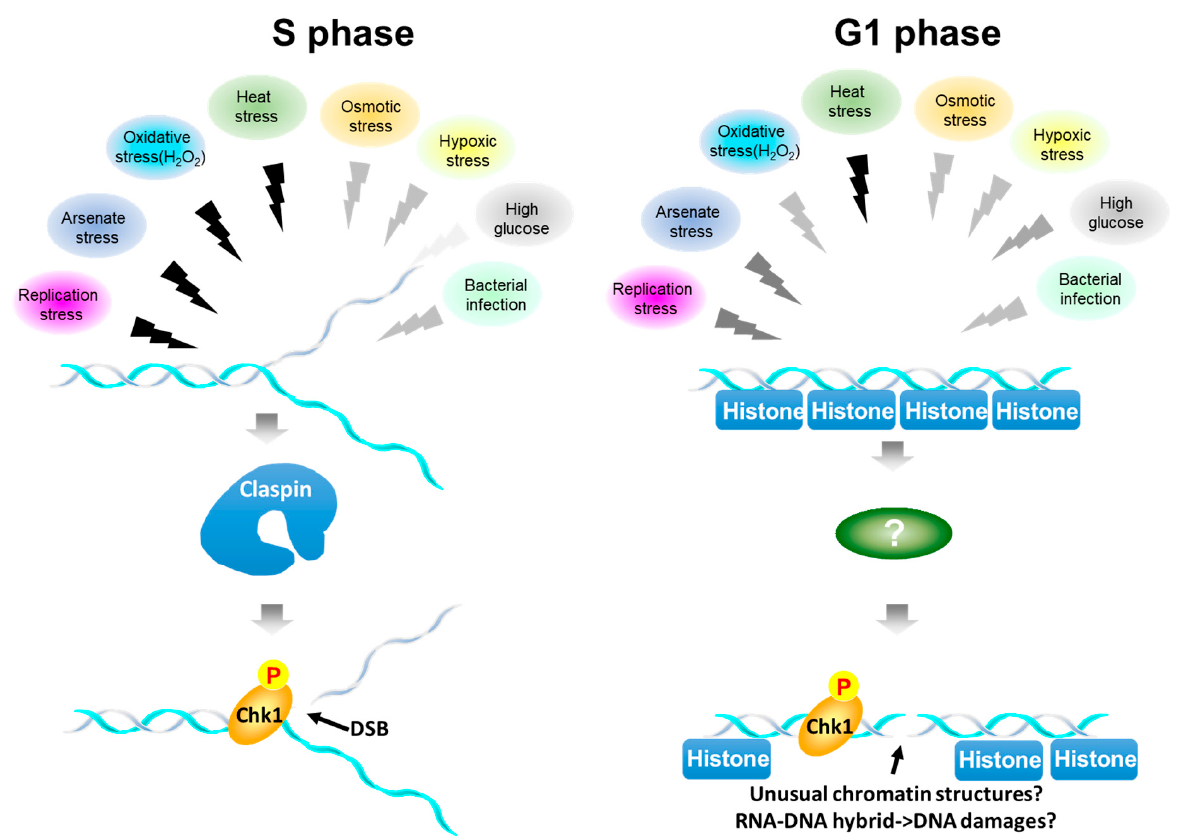
Figure 7. Summary of stress-mediated Chk1 activation during the cell cycle. Various biological stresses activate Chk1. Overall, Chk1 activation depends on Claspin. However, Chk1 activation is more strictly dependent on Claspin during S phase, while that in G1 phase is less dependent on Claspin. The colors of the zigzag lines represent the signal strength, black being highest and lighter gray being lower. During S phase (left), stresses with black arrows acutely inhibit DNA replication and may activate Chk1 and induce DNA damage at the stalled fork. Other signals also activate Chk1 albeit at a lower level. During G1 (right), all the signals can activate Chk1 to different extents. Heat, which strongly inhibits DNA replication, can vigorously activate Chk1 and DSB signal in G1 phase as well. During G1, γ − H2AX signals may represent actual DNA breaks or could be the results of reorganization of chromatin structures induced by stresses or those of RNA-DNA hybrid formation generated by stress-induced transcription, which may lead to DSB.